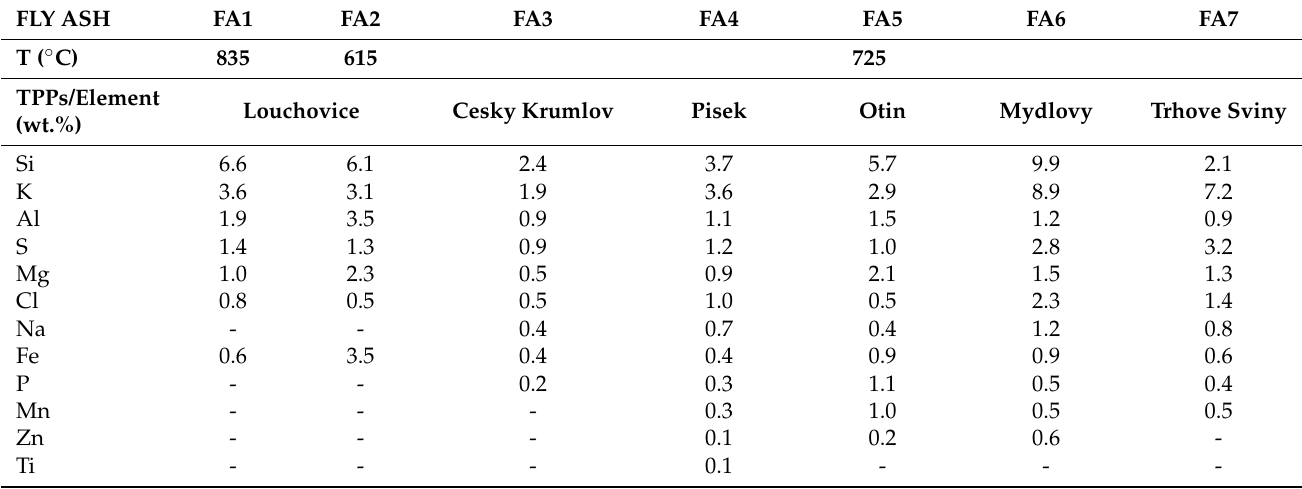
Table 3. Crystalline phases of FA1–7 were detected by XRD analysis.